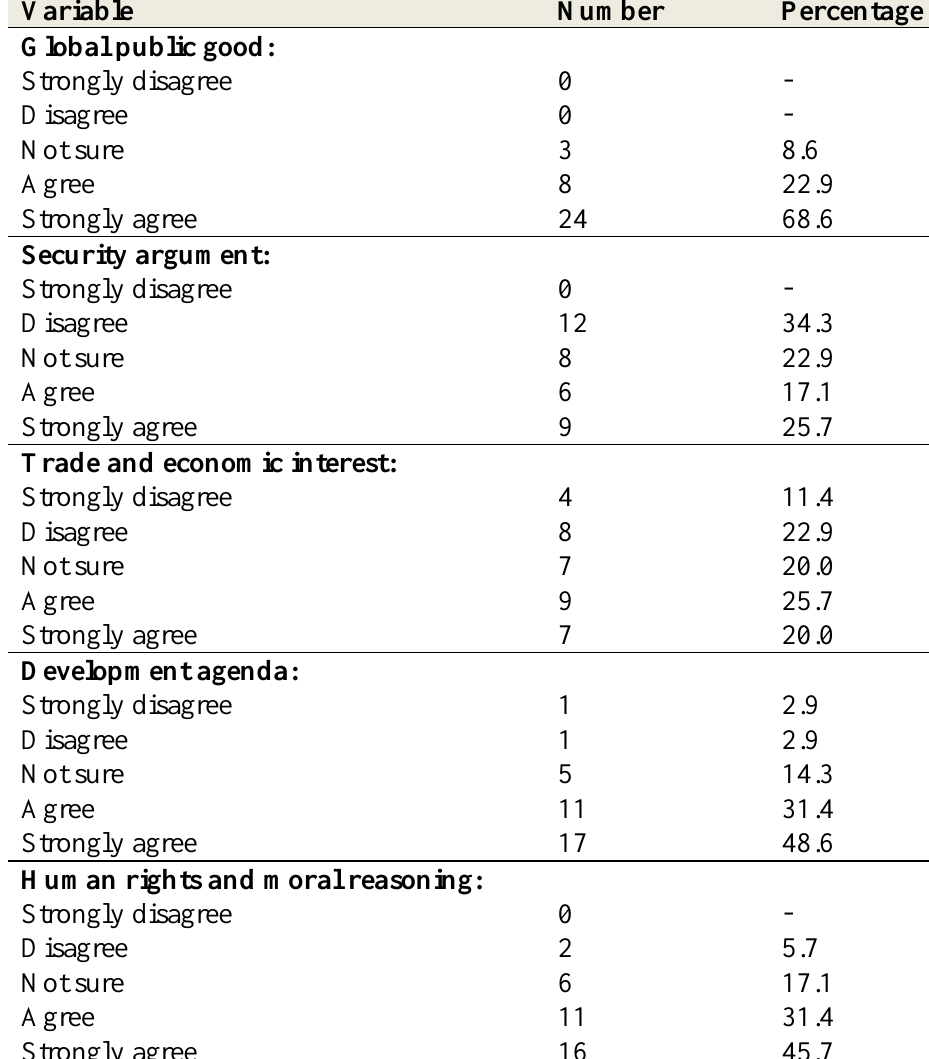
Table 2. Motivation and interest used to advance global